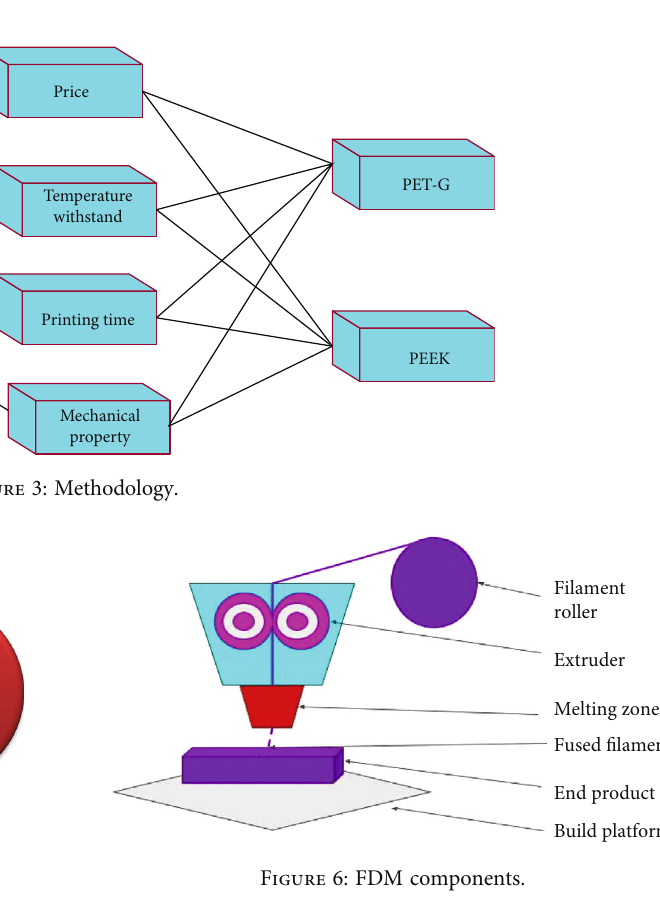
Figure 4: Comparison of the price of fi laments.